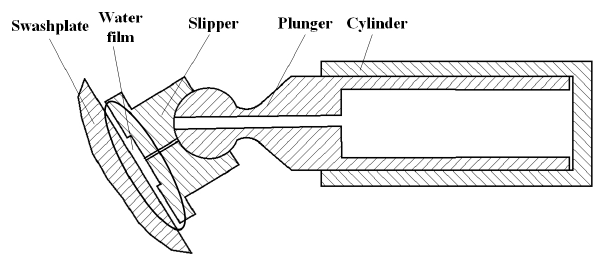
Figure 1. The structural profile of slipper pair.